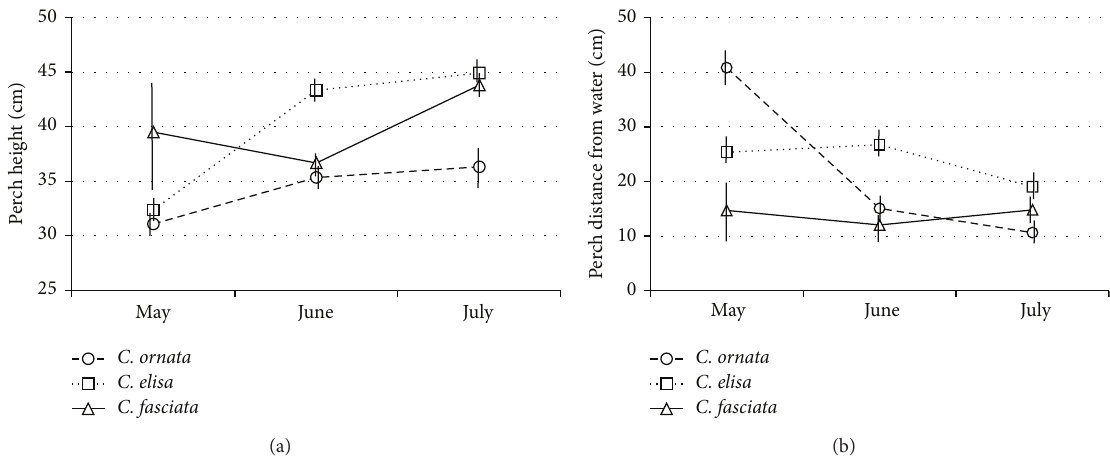
Figure 3: Monthly changes in (a) perch height (mean ± SE) and (b) perch distance from open water (mean ± SE) for Celithemis ornata , C. elisa , and C. fasciata at Ashmore Heritage Preserve, Greenville County, SC, USA.